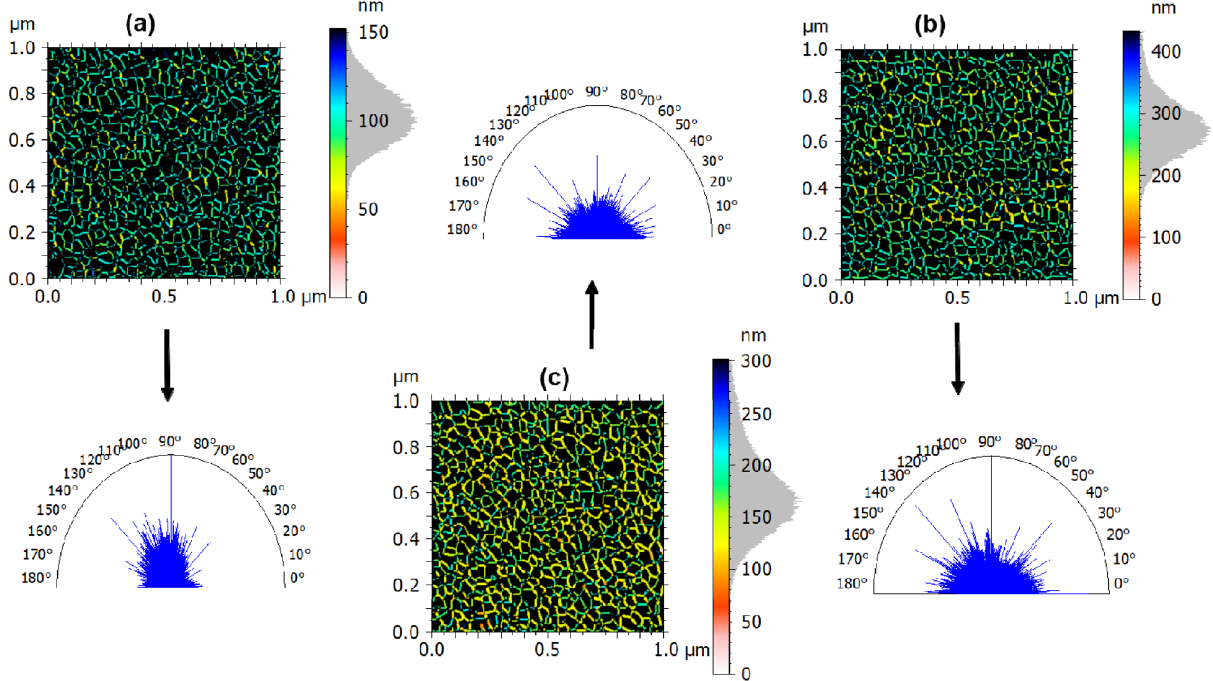
Figure 4. Furrows and surface isotropy of the surface microtexture of ( a ) Cu, ( b ) CuNi15, and ( c ) CuNi20 thin films.